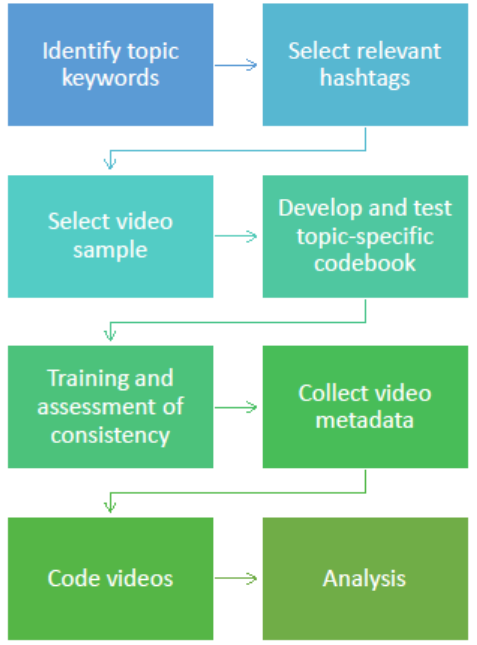
Figure 1. Overview of the process to investigate health-related topics on TikTok.